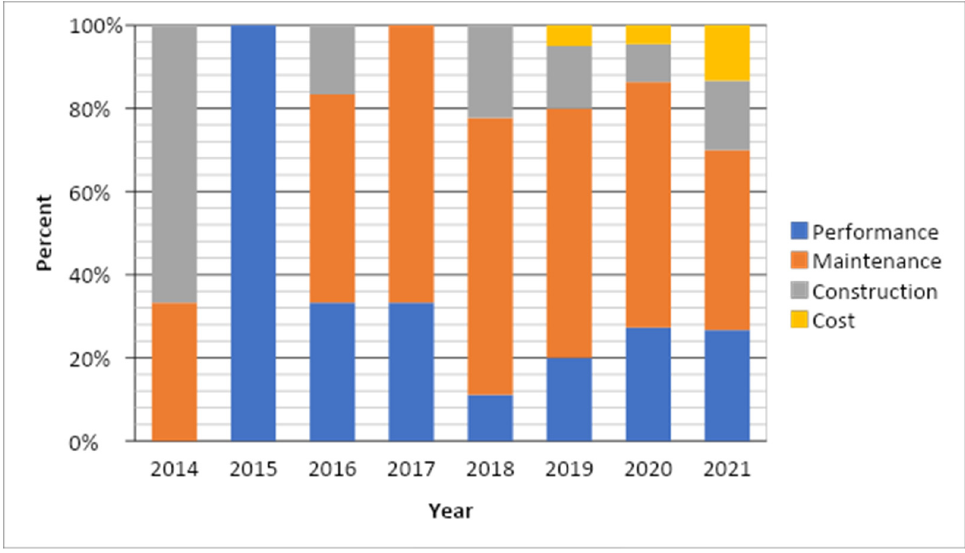
Figure 1. Literature search results. Table 1. Key topics of this